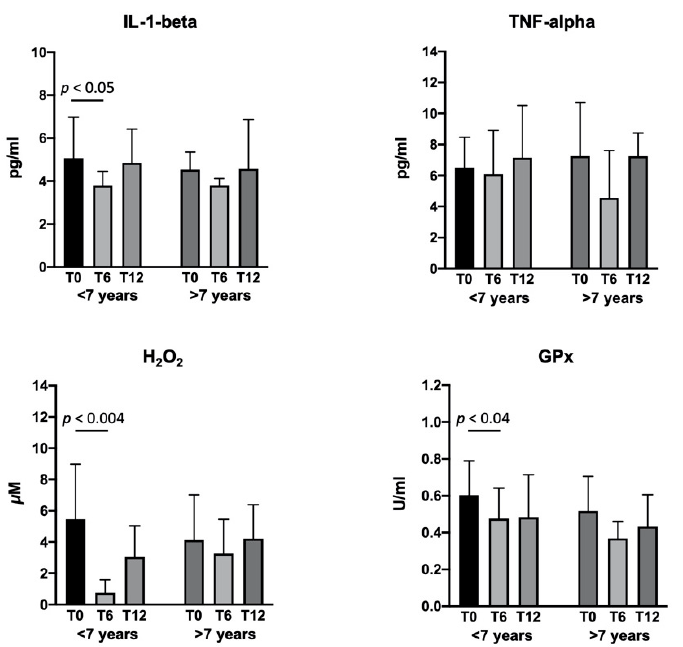
Figure 5. Levels of serum IL-1-beta, TNF-alpha, H 2 O 2 , and GPx measured in patients at baseline (T0) and after 6 (T6) and 12 (T12) months of treatment with flavocoxid. Eleven boys started treatment when aged less than seven years; six boys started flavocoxid when aged greater than seven years. Data are expressed as mean ± SD.